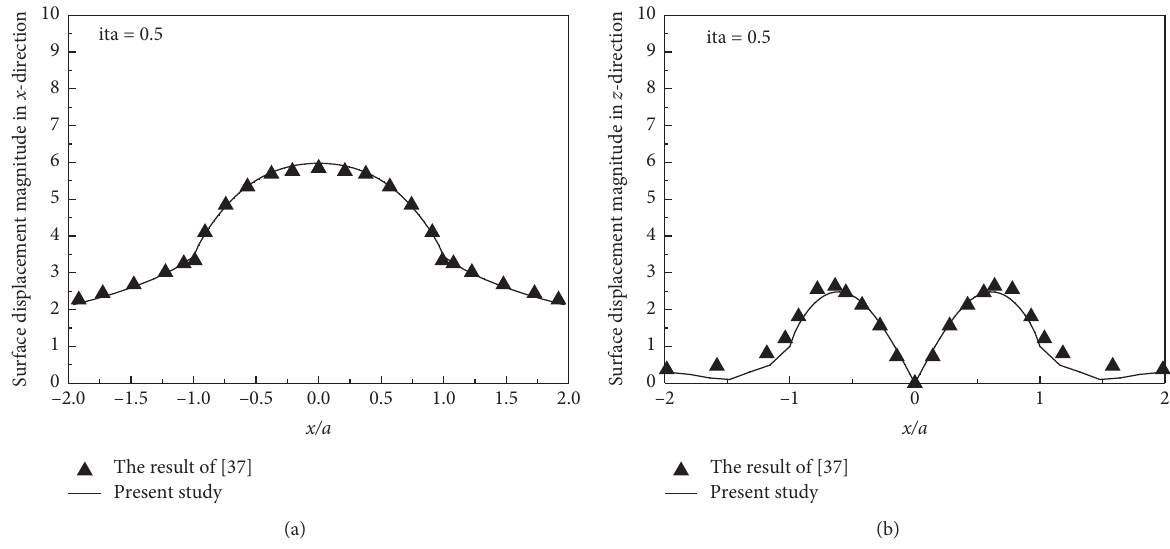
Figure 5: The displacement amplitude of surface node on x -axis of sedimentary basin: (a) the x -direction; (b) the z -direction. Table 3: List of some important notations and values. Symbol